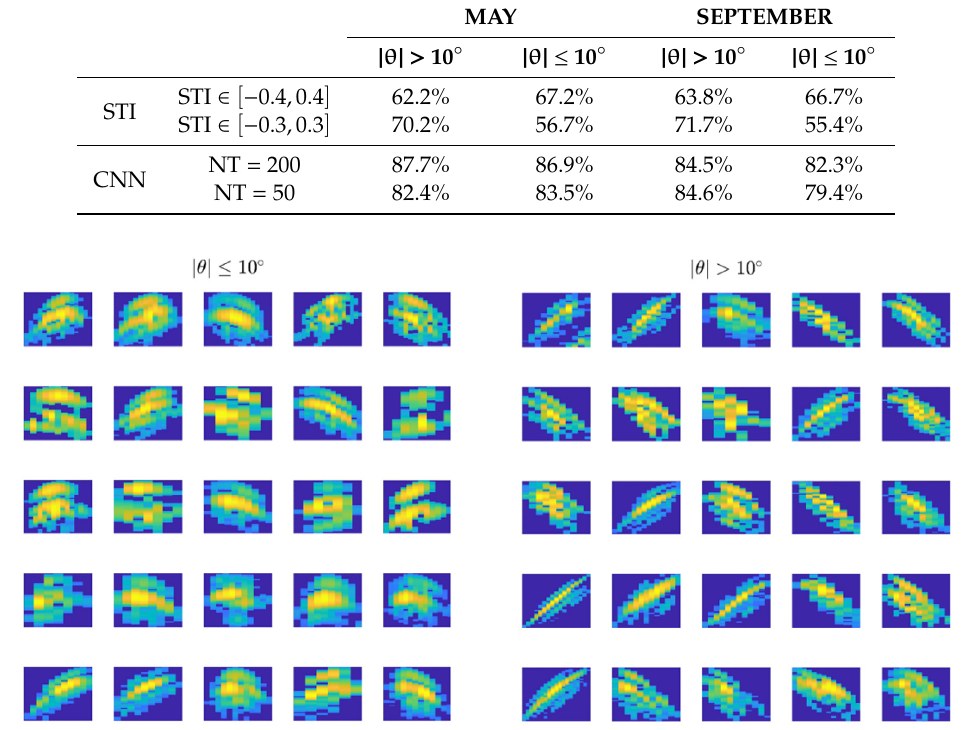
Figure 10. Sample of acoustic traces used in CNN training to discriminate tilted samples | θ | > 10 ◦ in the Acoustic–Optical (AO) measurements.